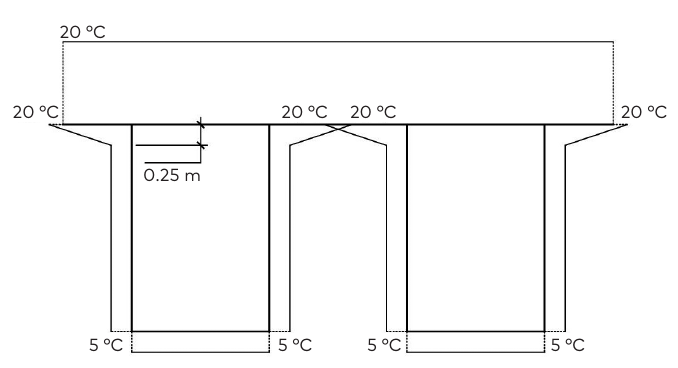
Figure 2. Temperature diagram of Rio-Niteroi bridge, recommended for climatic region of Rio de Janeiro,